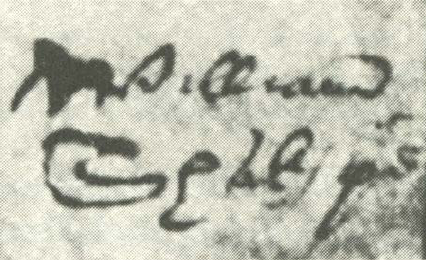
Fig. 2 – Signature n. 2 on the Blackfriars Gatehouse purchase deed (1613)